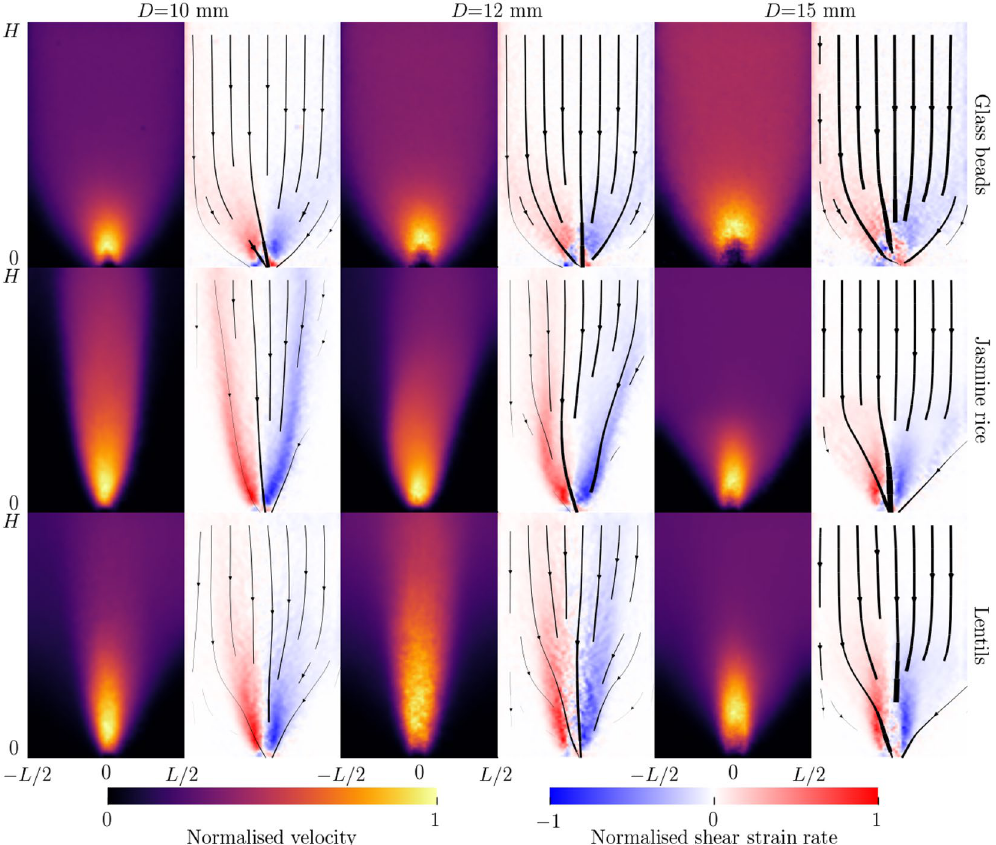
Figure 3. Velocity magnitude and shear strain rate during developed flow, as measured from detector A. Black lines indicate streamlines of the velocity field, with thickness representing magnitude. Left to right: D = 10, 12 and 15 mm. Top: Glass beads. Middle: Jasmine rice. Bottom: Red lentils. Left to right , top to bottom: Normalisation velocity is 28.4, 37.4 and 49.6 mm/s; 18.4, 37.5 and 56.3 mm/s; 17.6, 22.6 and 65.2